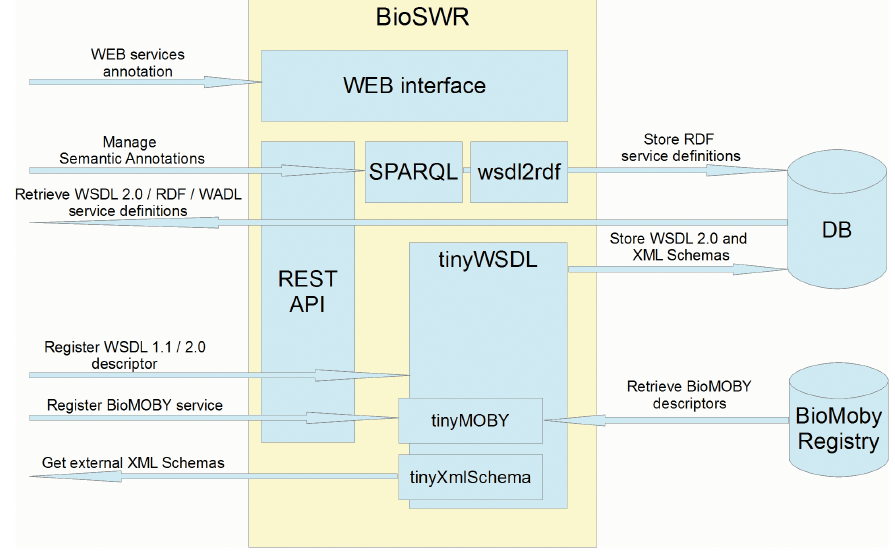
Figure 1. BioSWR general architecture.